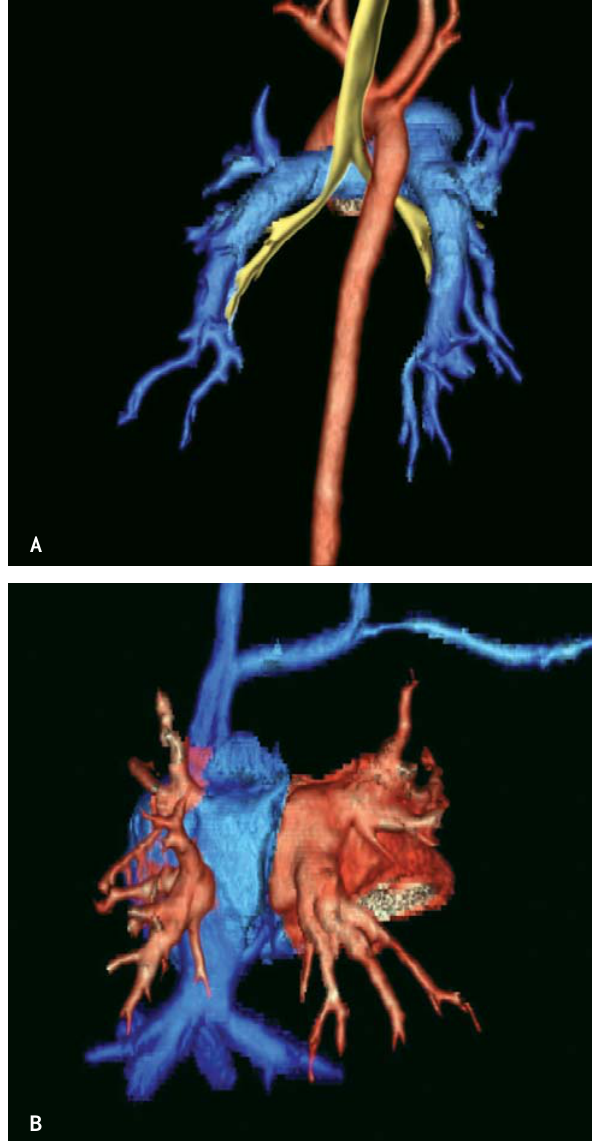
Fig. 3 – Tomografia de múltiplos detectores após reconstrução em 3D: (A) Vista posterior com aorta descendente à direita,